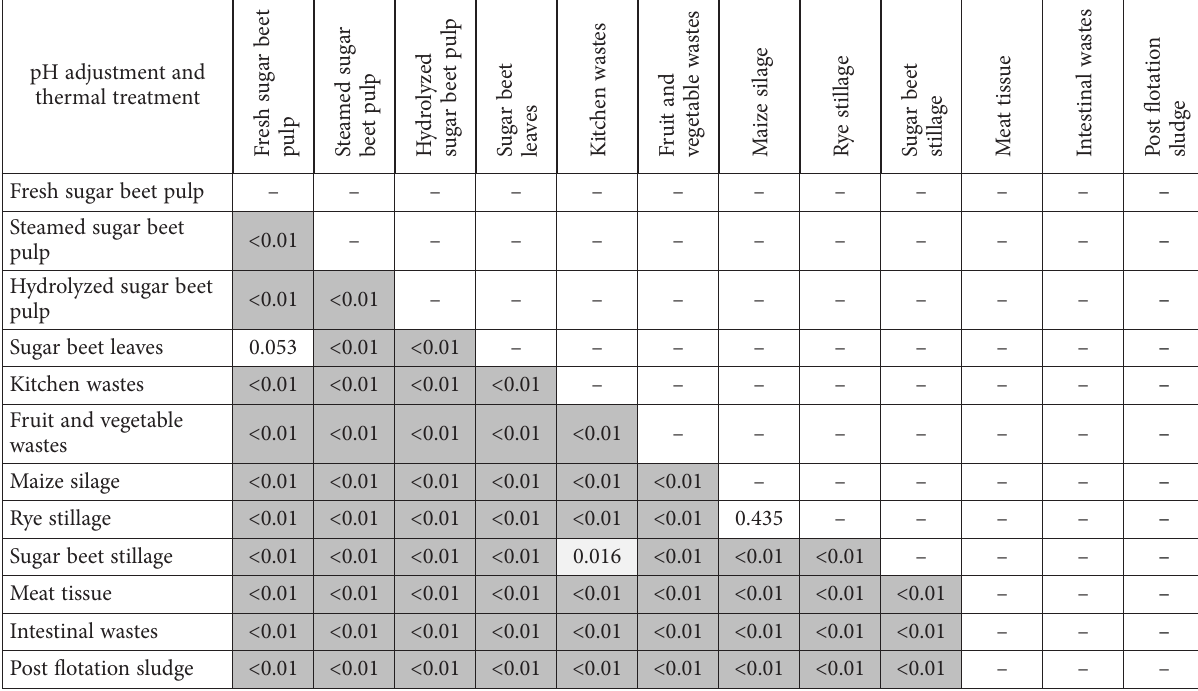
Table 4S. Statistical comparison of hydrogen production from batch test with thermal treatment and pH adjustment (ANOVA, p value, Tukey ’ s test)